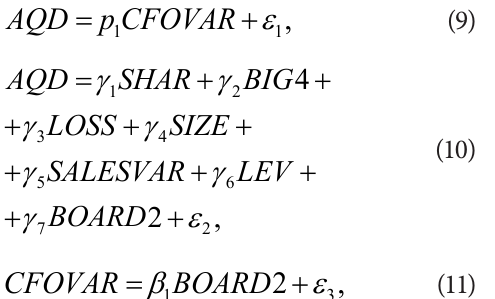
Figure 1. Research framework